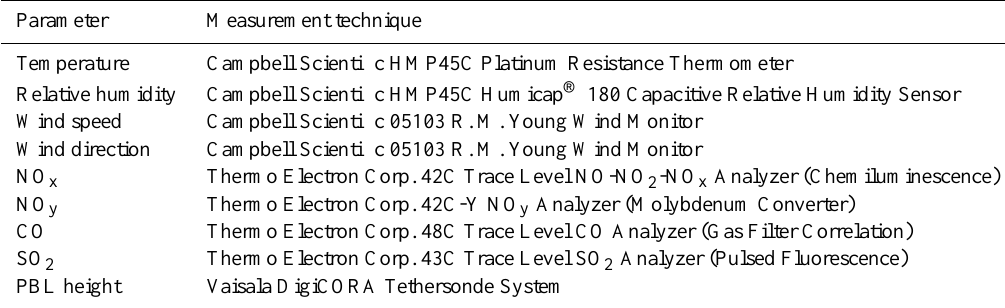
Table 1. Measurement techniques for air pollutants and meteorological parameters.